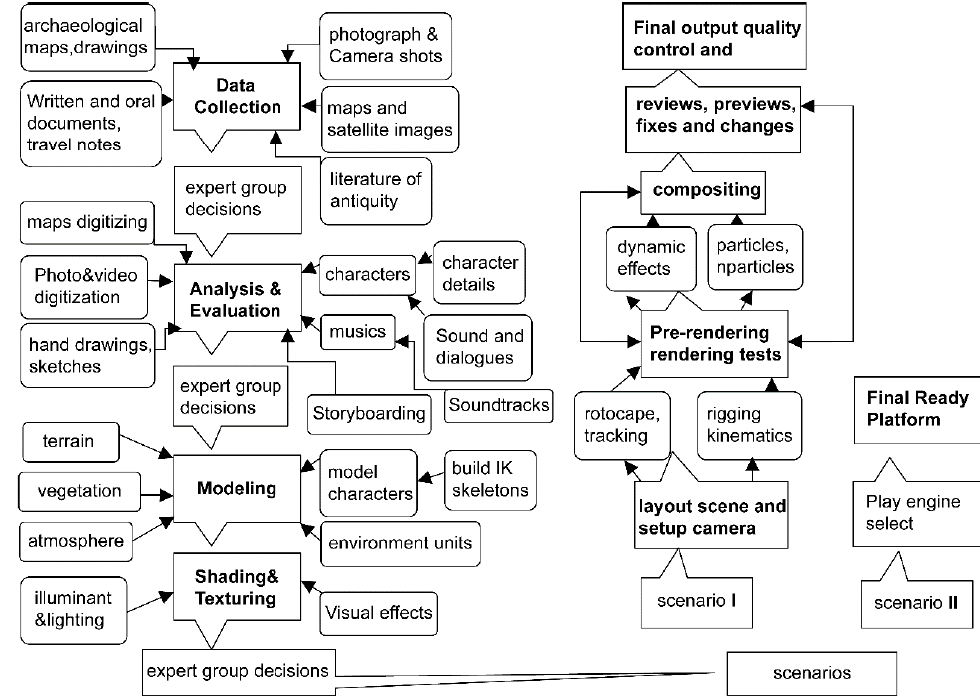
Figure 1. Visualization process for the ancient city of Antioch.